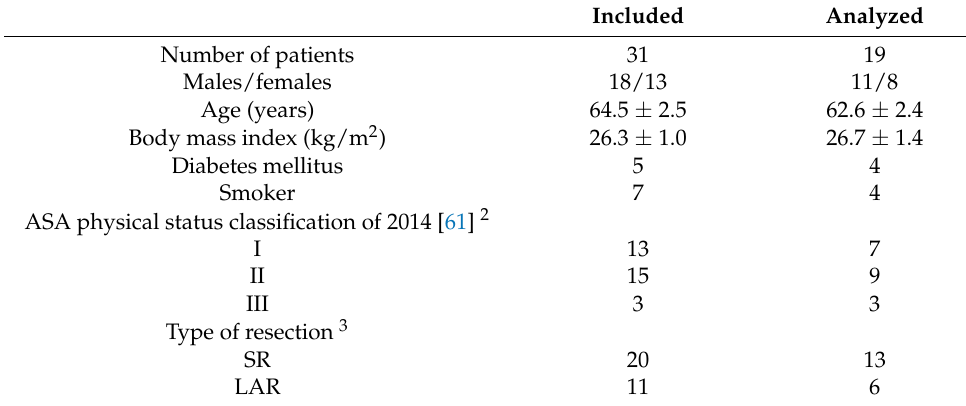
Table 4. Patient characteristics 1